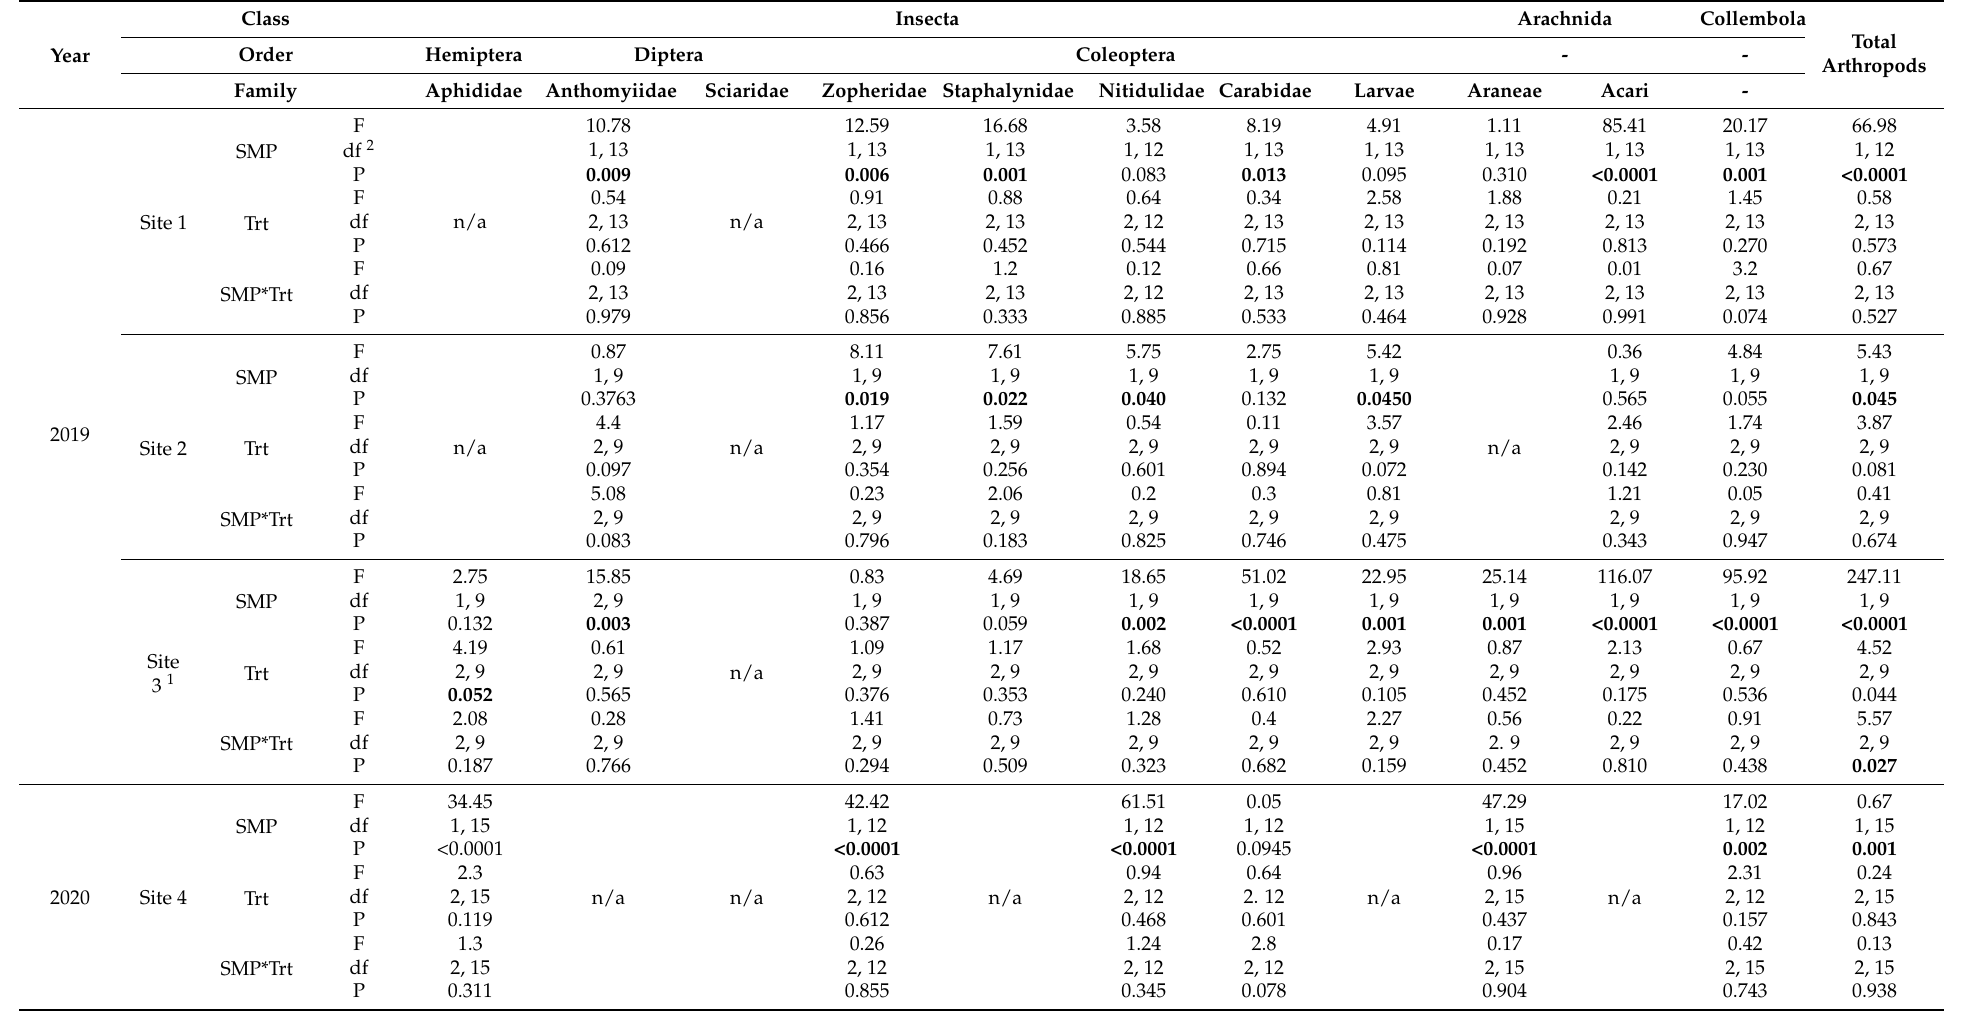
Table 4. Analysis of covariance with significant interactions or main effects per site and year for each arthropod taxa composing more than 1% of the total